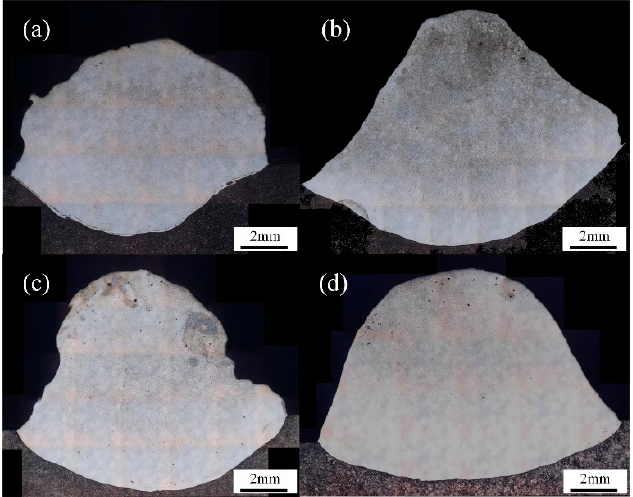
Figure 12. The cross sections of welding joints with different filling rate. ( a ) 15% filling rate; ( b ) 20% filling rate; ( c ) 24% filling rate; ( d ) 28% filling rate.